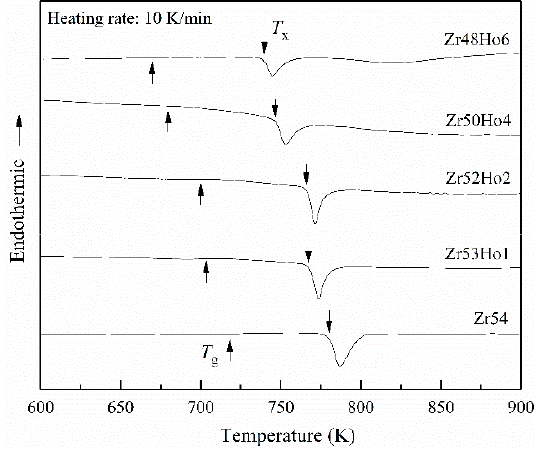
Figure 2. DSC curves of Zr 54 − x Cu 29 Ni 7 Al 10 Ho x ( x = 0, 1, 2, 4, 6) BMGs. Table 1. Thermal parameters of Zr 54- x Cu 29 Ni 7 Al 10 Ho x ( x = 0, 1, 2, 4, 6) BMGs. Composition (in at.%)